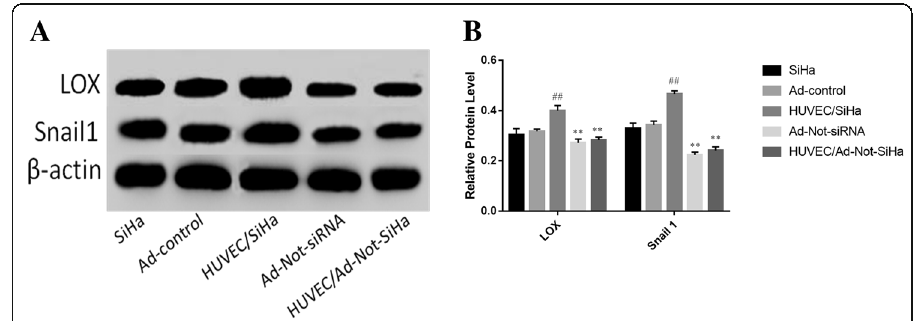
Fig. 4 Changes in LOX and Snail1 protein expression in cells. a Western blotting experimental strip; b Western blotting experimental strip semi-quantitative analysis. Compared with the Ad-Control group, ## P < 0.01; compared with the HUVEC/SiHa group, ** P < 0.01